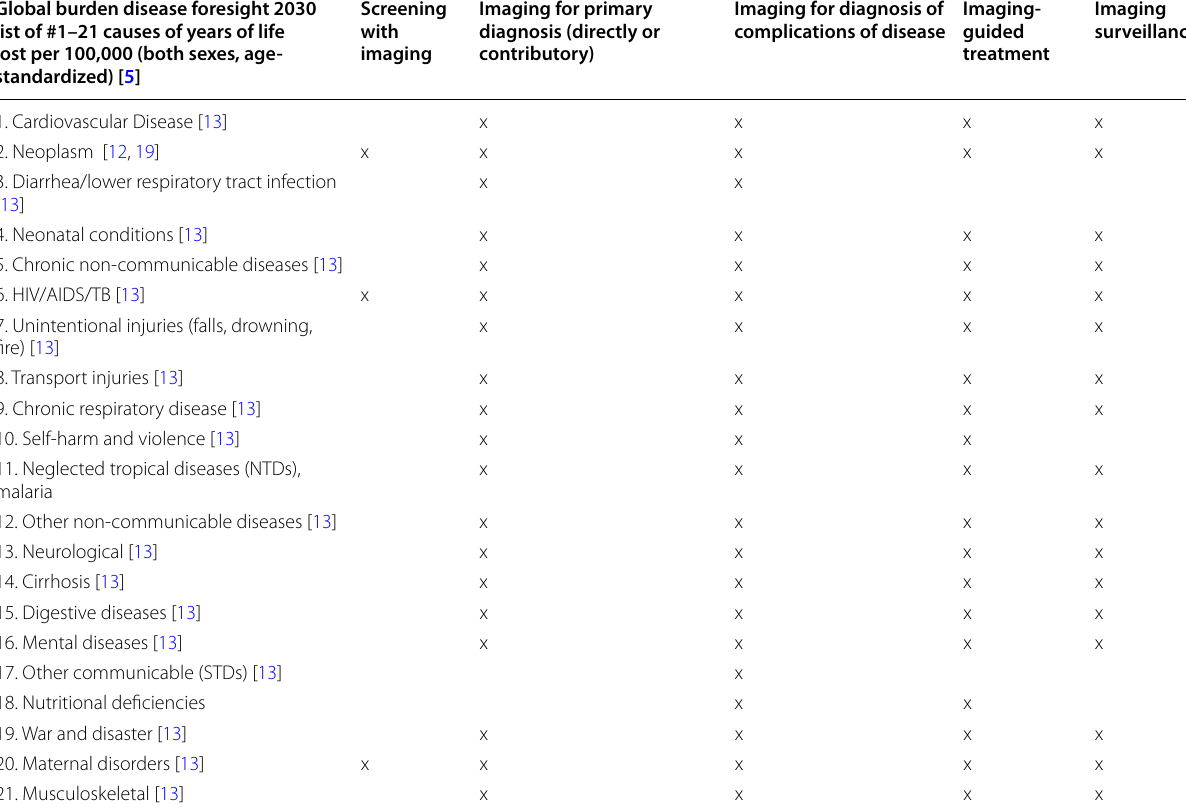
Table 1 Intersection of Forecasted (2030) Global Burden of Disease—top 21 causes—with Imaging Indication Global burden disease foresight 2030 list of #1–21 causes of years of life lost per 100,000 (both sexes, age- standardized)